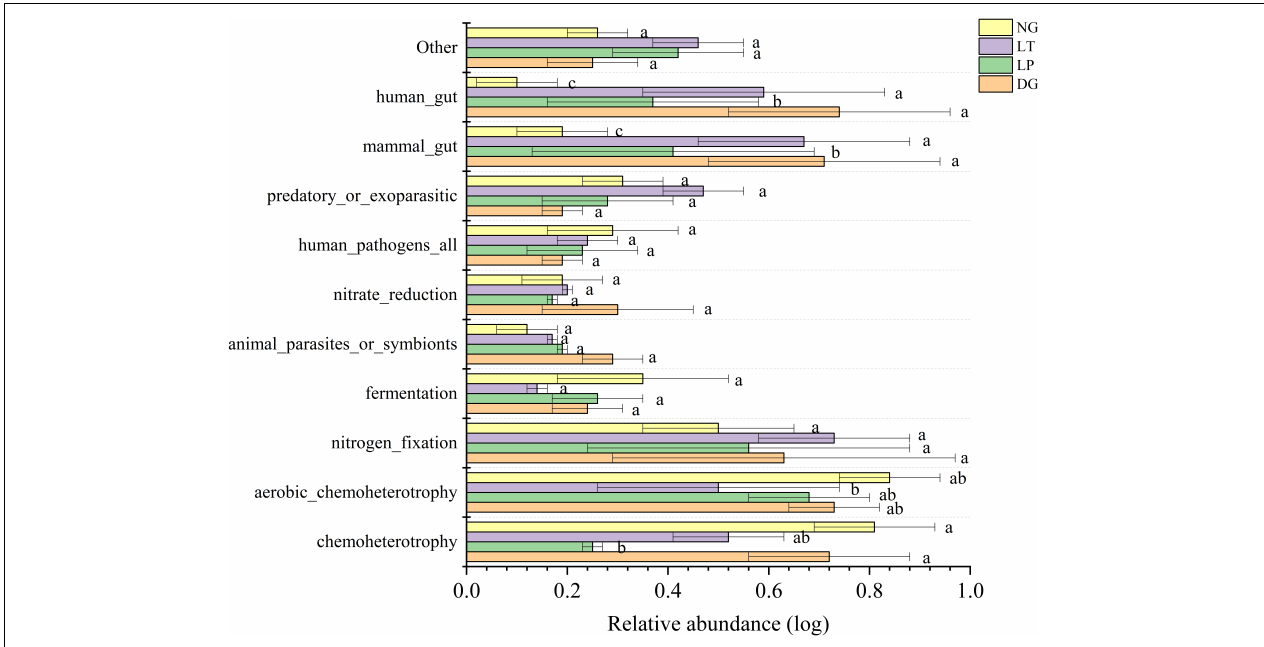
FIGURE 5 | Relative abundance of soil bacterial community for ecological function in different vegetation restorations. Different lowercase letters are significantly different among different sites ( p < 0.05). DG, Dactylis glomerata ; LP, Lolium perenne ; LT, Trifolium repens ; NG, natural grassland.